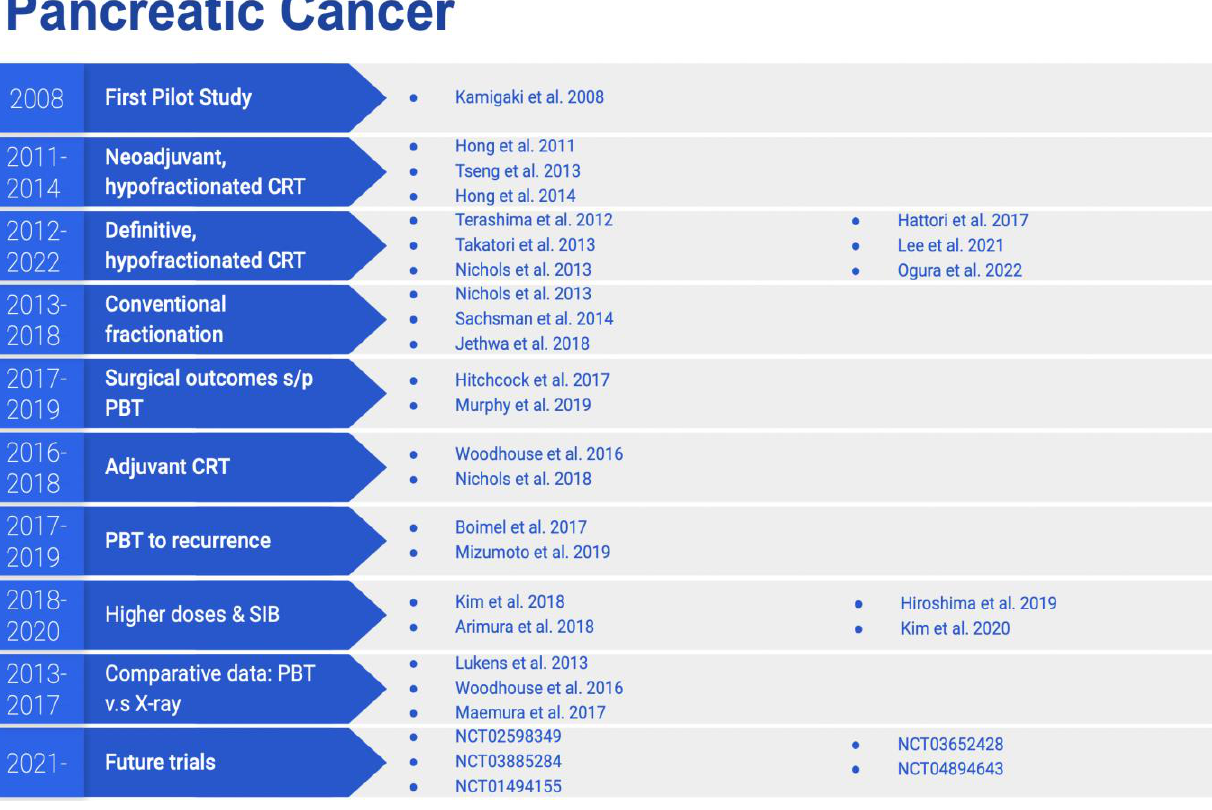
Figure 2. Studies on proton therapy for the treatment of pancreatic cancer, stratified by their special focus and time of publication.